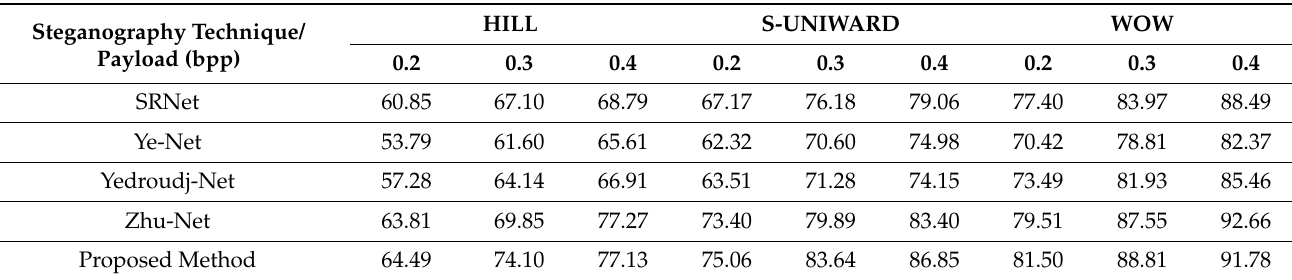
Table 5. Performance assessment while considering Case